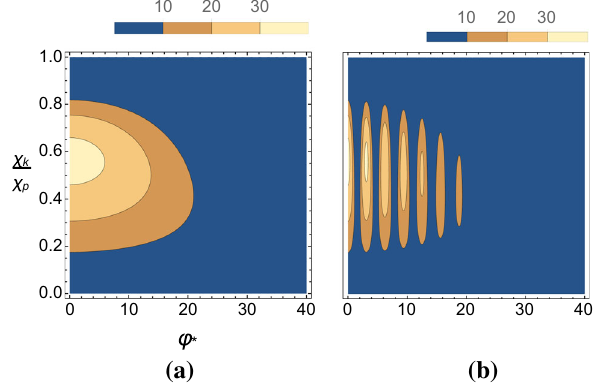
Fig. 14 The pseudo-scalar yield, P − , is plotted as a function of ϕ ∗ and χ /χ δ = 0 in a a Gaussian pulse background and b a laser pulse k p for background, with a pulse duration of 10 fs and κ 0 = 1 . 55